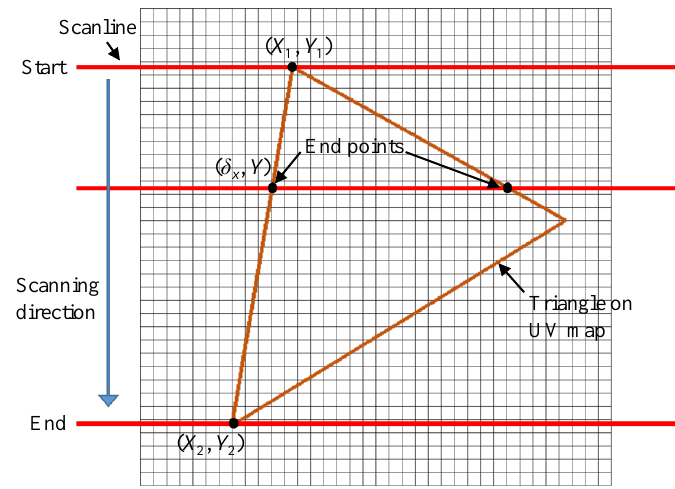
Figure 7. A scanline method to evaluate all pixels inside a triangle.